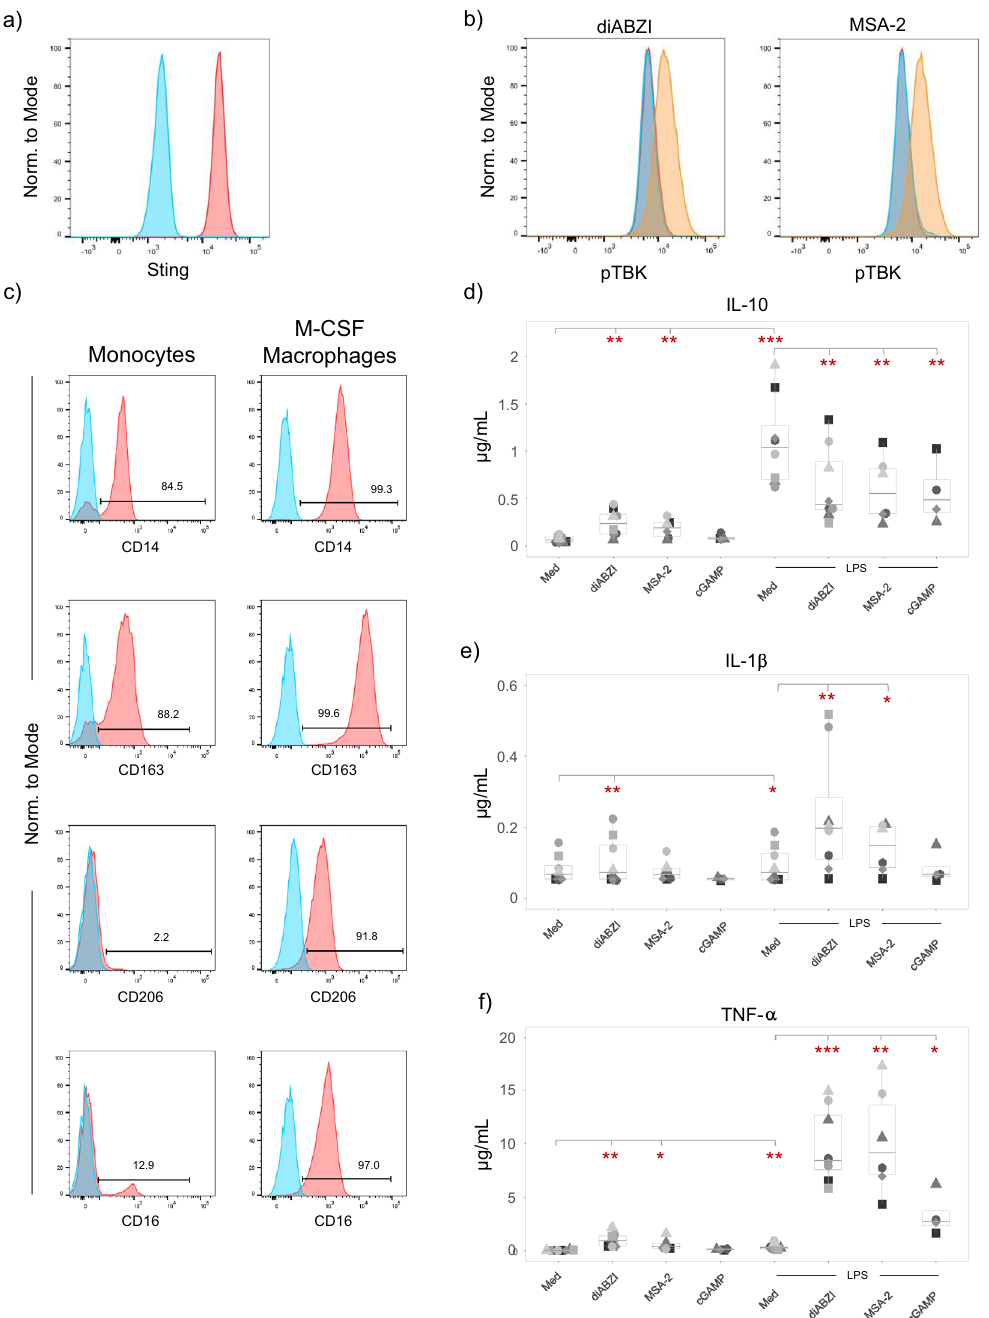
Figure 6. Responsiveness of M-CSF differentiated macrophages to STING ligands. Purified monocytes were cultured for 6 days in the presence of 50 ng/mL M-CSF. ( a ) M-CSF macrophages expressed STING as revealed by flow cytometry. Blue: FMO control; red: anti-STING-AF488. ( b ) M-CSF macrophages were stimulated with 100 nM diABZI or 25 µM MSA-2. After 60 min, phosphorylation of TBK1 was analyzed by flow cytometry using anti-pTBK1-PE antibody. Red: medium control; blue: lower dose of diABZI/MSA-2; beige: higher dose of diABZI/MSA-2. ( c ) Surface marker expression on paired samples of freshly isolated monocytes (left) and M-CSF macrophages (right). Blue: isotype controls; red: specific antibody. ( a – c ) Representative out of three experiments are shown. ( d – f ) M-CSF macrophages were cultured in medium only or were stimulated with 100 ng/mL LPS, 100 nM diABZI, 25 µM MSA-2 (left part), or the combination of LPS with STING ligands as indicated (right part). Supernatants were collected after 24 h, and cytokines were quantified by ELISA. ( d ) IL-10 (n = 5–8). ( e ) IL-1β (n = 6–8). ( f ) TNF-α (n = 3–6). Statistical significance between groups as indicated by the horizontal bars was calculated by paired Student’s test. Red asterisks indicate the level of significance between stimulated and unstimulated (medium) samples (left part) or between LPS plus STING ligands versus LPS only (right part). *p < 0.05, **p <